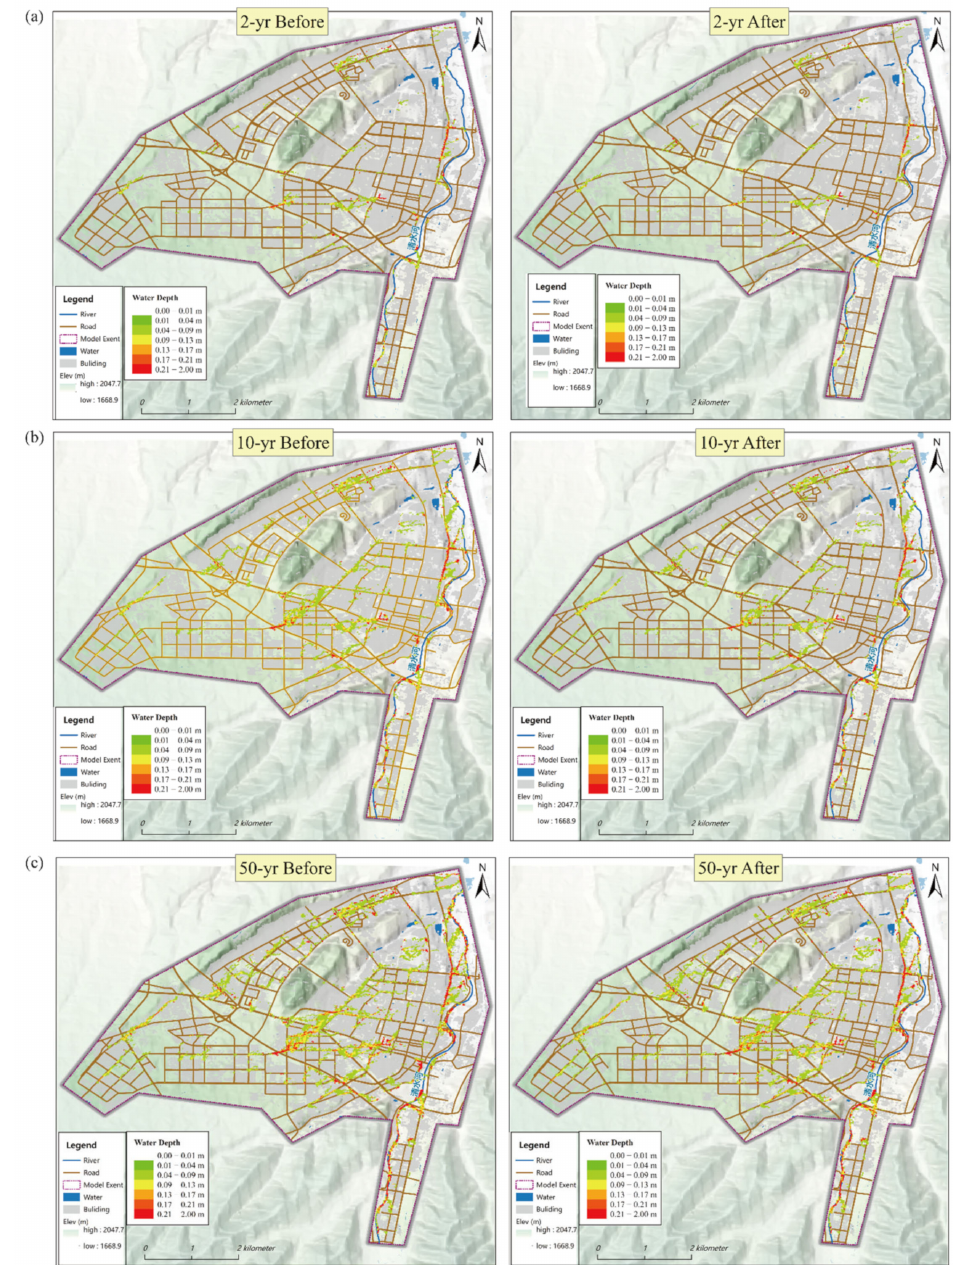
Figure 9. The distribution of waterlogged points under different rainfall return periods. ( a ) 2 years; ( b ) 10 years; ( c ) 50